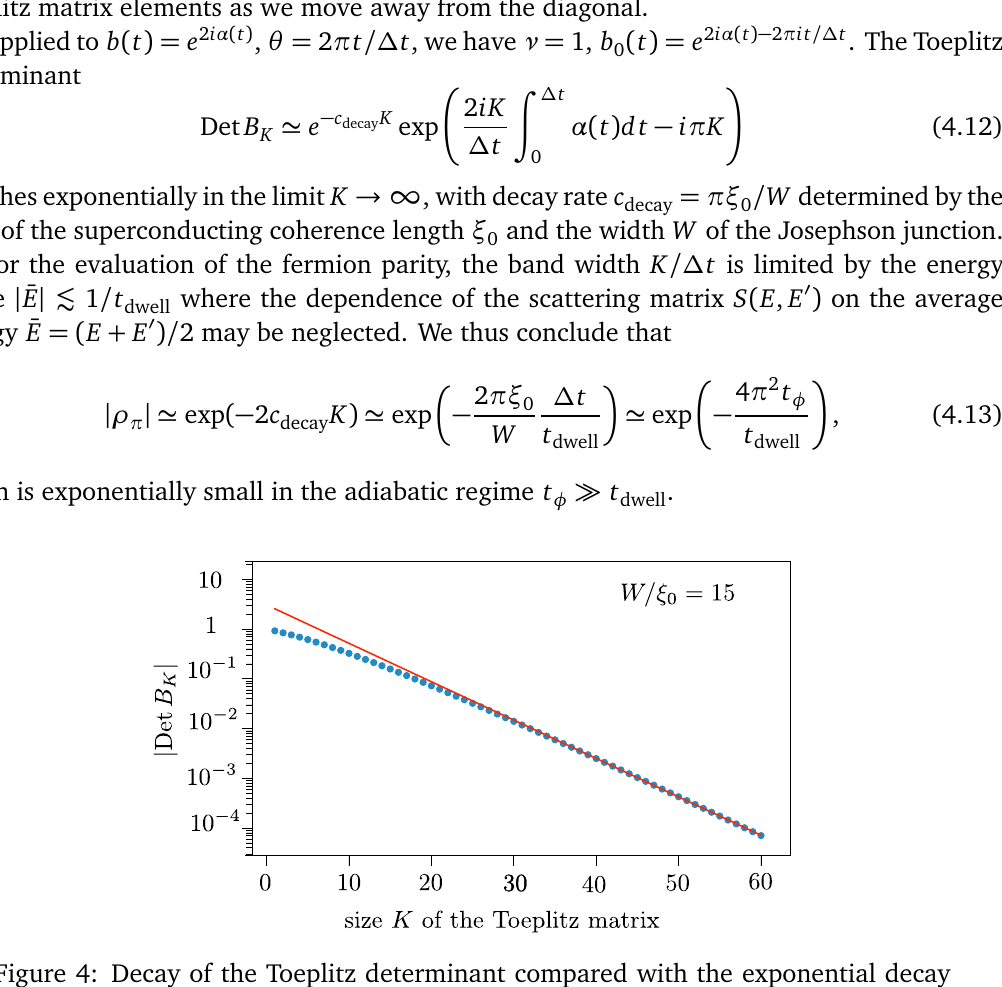
= 15. The 0 ( k , k (cid:48) ) | (cid:39) exp ( − c | k − k (cid:48) | ) . The K decay